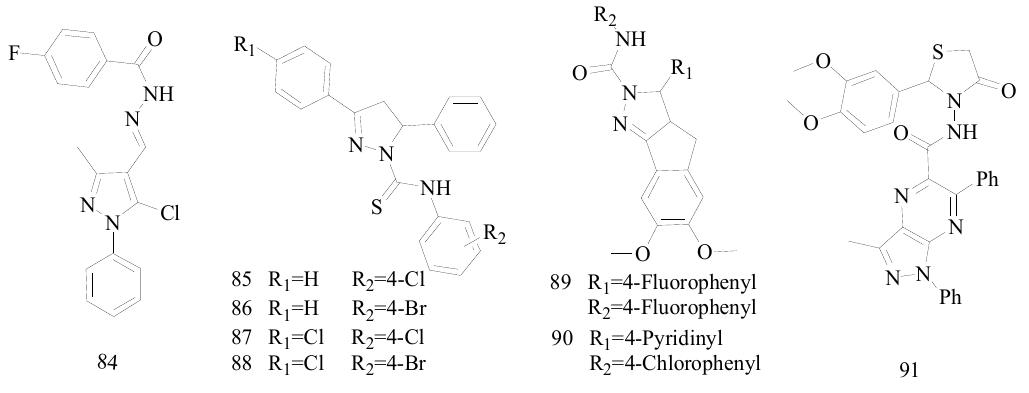
Figure 5. Structures of compounds 84 – 91 .